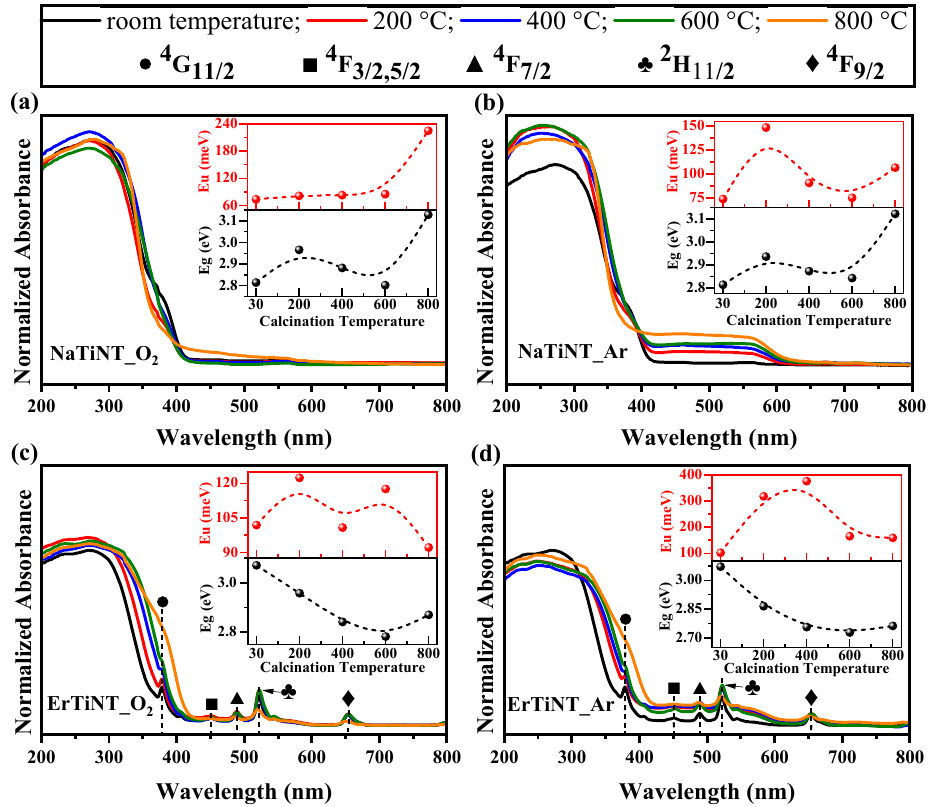
Figure 7. UV–Vis absorption spectrum of NaTiNTs heat treated in air ( a ) and Argon atmosphere ( b ), and ErTiNTs heat treated in air and argon atmospheres, Figures ( c ) and ( d ), respectively. The dashed lines in the ErTiNTs spectra show absorption peaks that change with increasing temperature. The symbols on the absorption peaks indicate the electronic transitions from the ground state 2 I 15/2 . The inserts in the graphs show the band gap and Urbach energy variations of the samples with increasing temperature. The upper caption is the same for all samples.